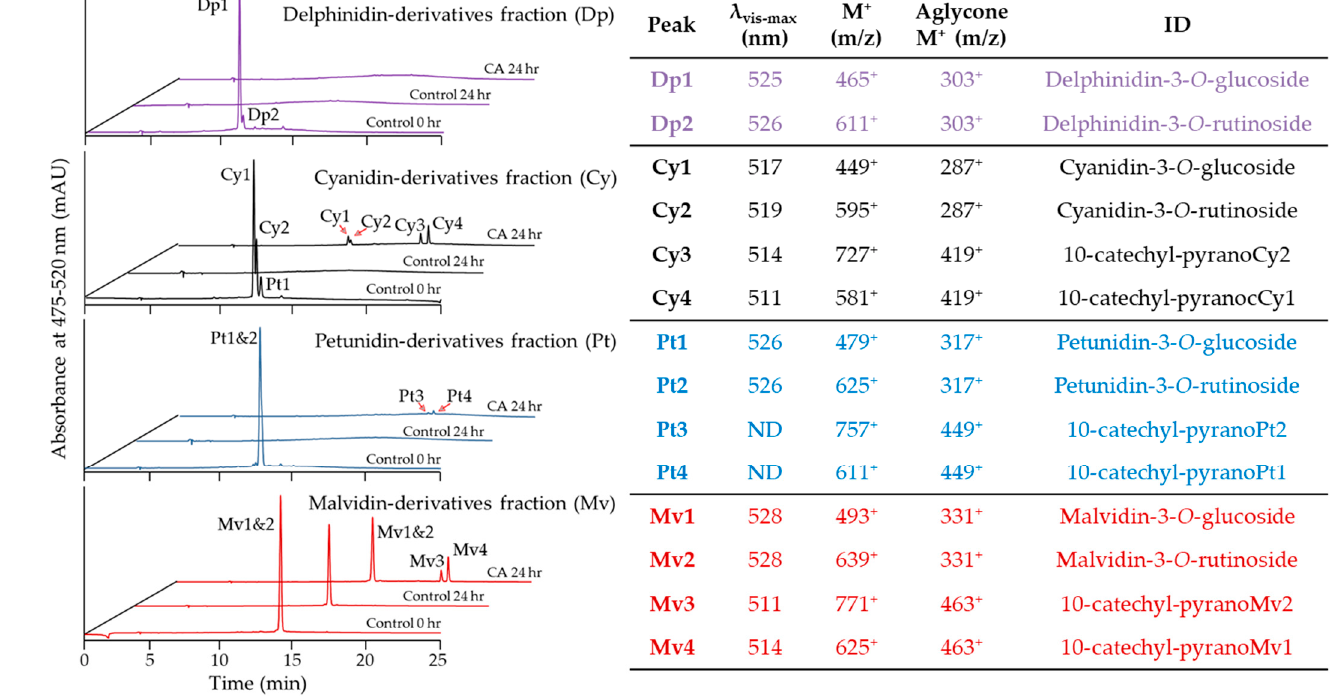
Figure 5. Anthocyanins from fractions with different aglycones and PACN formation after 24 h of 45 °C incubation with caffeic acid (CA). Chromatograms show the max plot in the 475–520 nm range. Table shows the wavelength of maximum absorption in the visible range ( λ vis-max ), mass-per-charge ratio ( m / z ) of the main ion and its aglycone, and tentative identity (ID).